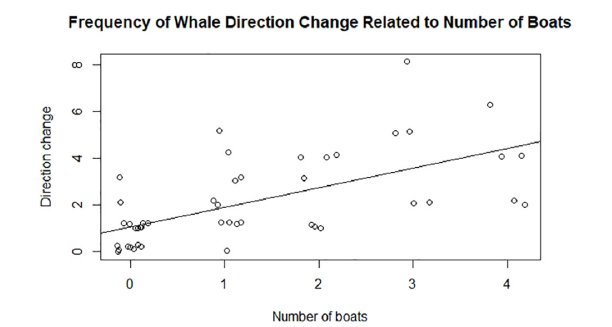
FIGURE 5 | Megaptera novaeangliae. Observed correlation between the number of boats and the total number of direction changes while conducting group-follow behavioral